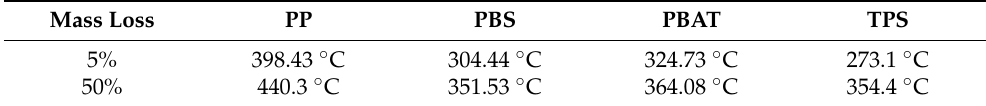
Table 3. TGA analysis to determine the temperatures of 5% and 50% mass loss for four polymers. Mass Loss